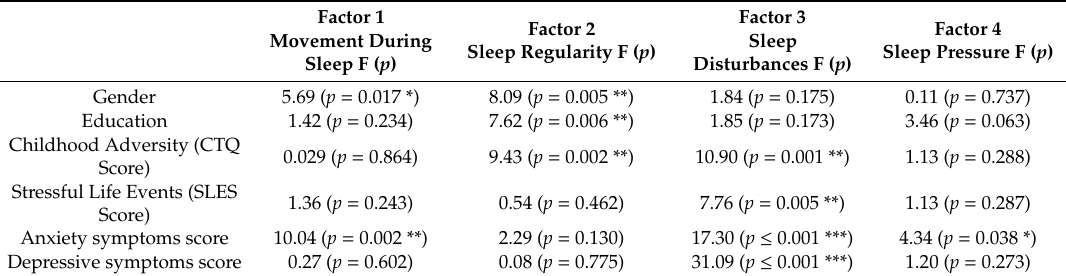
Table 4. Childhood trauma, stressful life events, and mental health symptoms e ff ects on sleep patterns